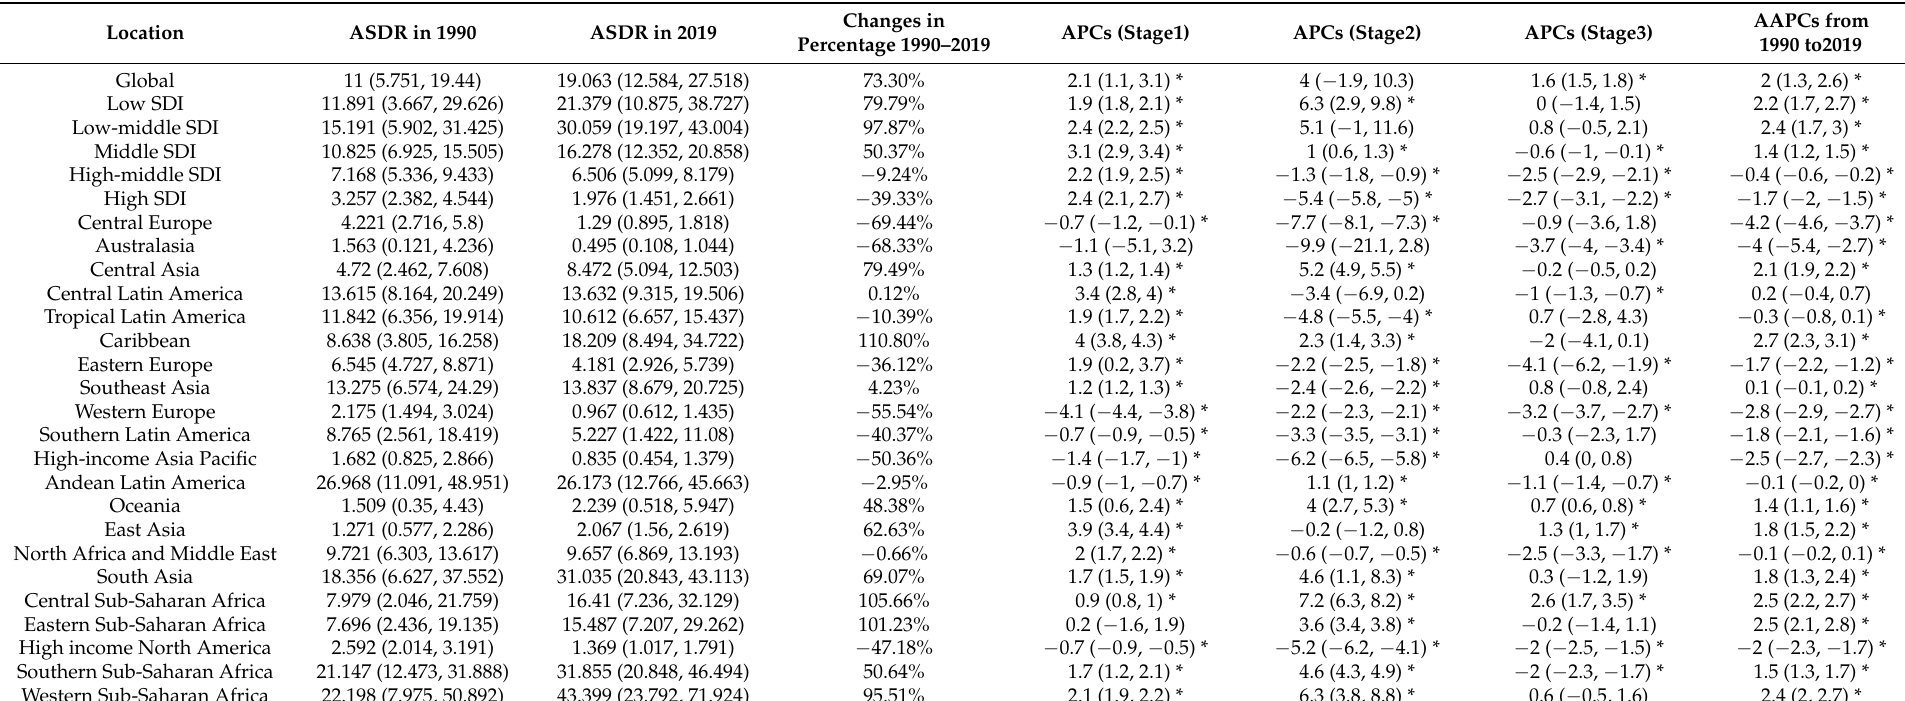
Table 2. Age-standardized disability-adjusted life years rate, changes in the percentage, annual percentage changes, and average annual percentage changes in PM2.5-related neonatal infections from 1990 to 2019 globally and in different